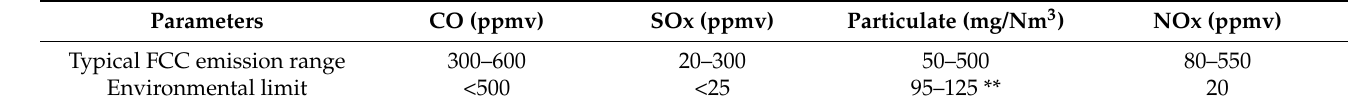
Table 8. Flue gas emission regulation in FCC regenerator unit